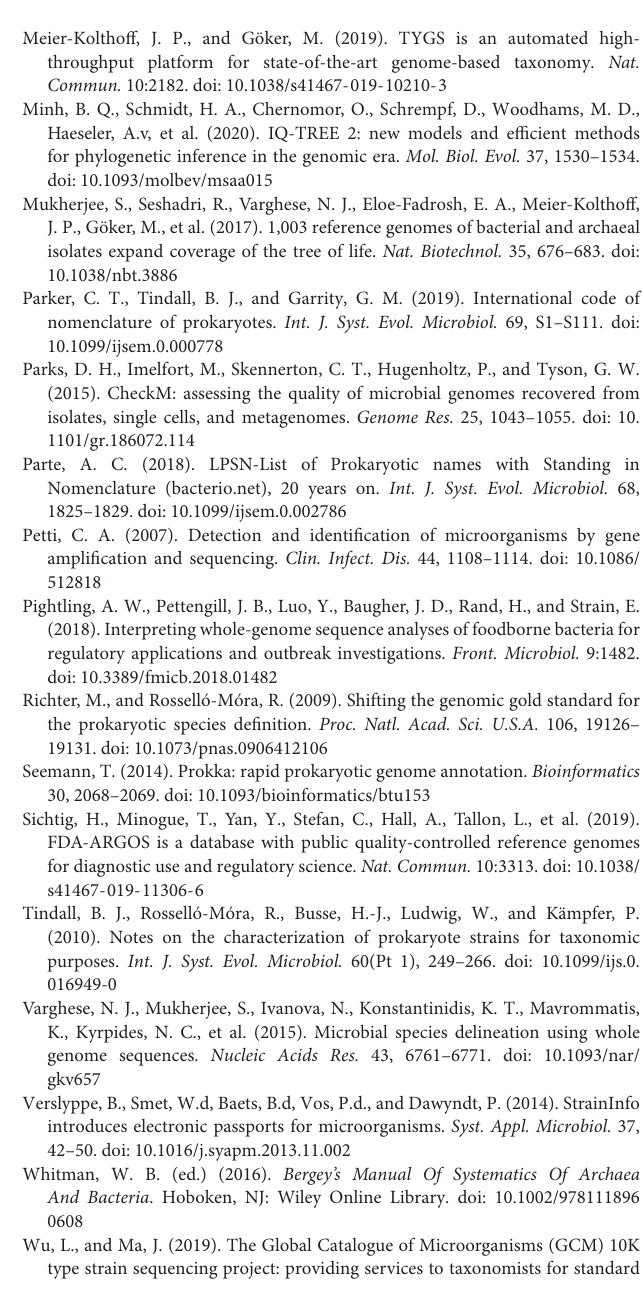
Supplementary Figure 1 | Example phylogenetic analysis of 17 Salmonella genomes from a factory. Supplementary Figure 2 | Distribution of ANI value between target and non-target top 1 results. Red, with 16S non-target top 1 results; Green, with KmerFinder non-target top 1 results. ANI calculation between the query assembly